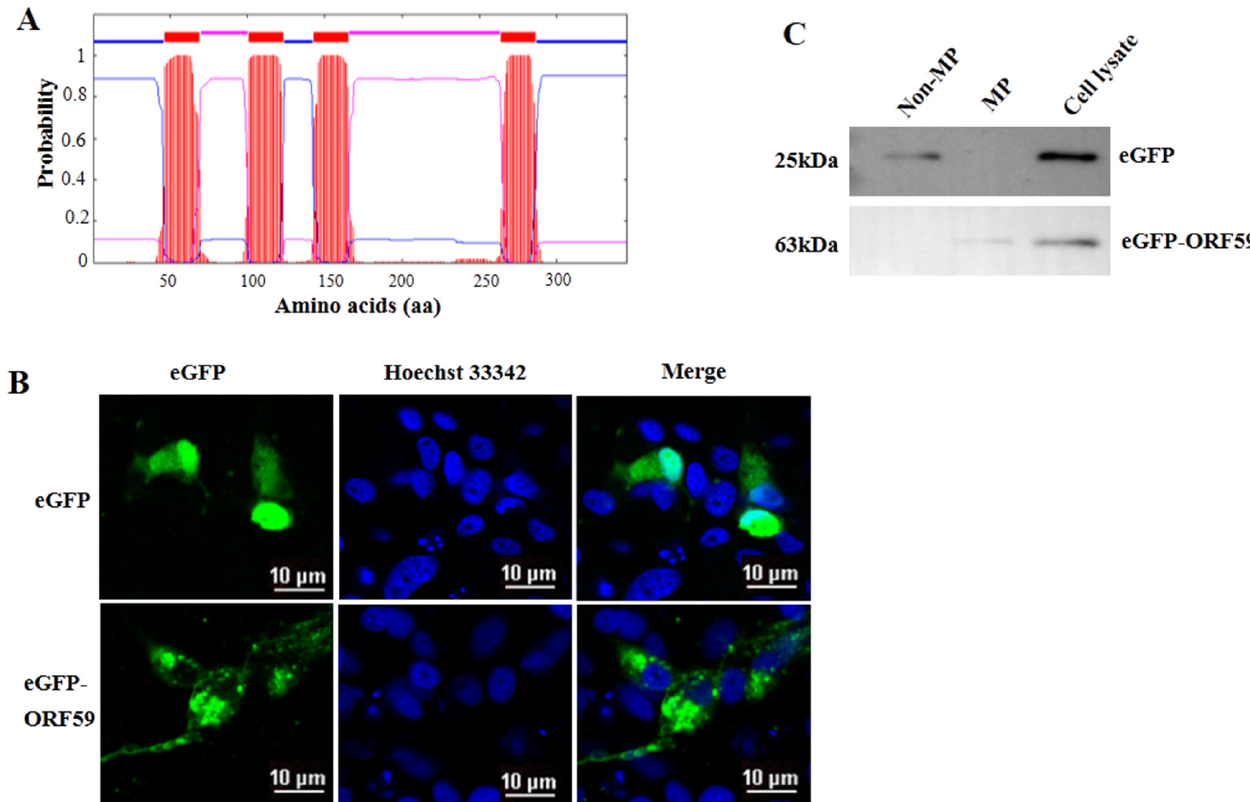
Figure 2. ORF59 is a membrane protein in CCO cells. ( A ) Prediction of transmembrane regions of the ORF59 protein. The ORF59 amino acid sequence was analyzed using TMHMM software. The plot shows the probability of transmembrane helices, and the positions of amino acids are indicated. ( B ) Intracellular localization of ORF59 detected by expression of an eGFP-ORF59 fusion protein. The plasmids were transfected into CCO cells. Representative images were obtained under fluorescence channels. Bar = 10 µ m. ( C ) Analysis of ORF59 expression using Western blotting. Membrane proteins (MP) and nonmembrane proteins (Non-MP) were extracted from CCO cells transfected with pEGFP-ORF59. eGFP and the ORF59 fusion protein were probed using specific anti-eGFP antibodies and samples of cell lysates served as controls. The predicted molecular weights are shown on the left. CCO, channel catfish ovary; eGFP, enhanced green fluorescent protein.